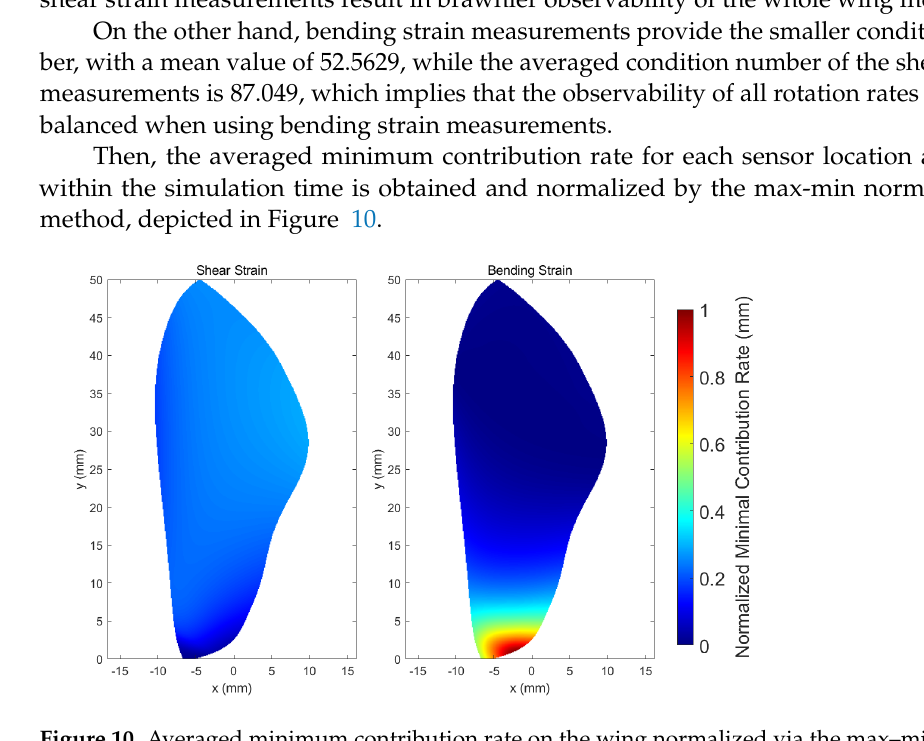
Figure 10. Averaged minimum contribution rate on the wing normalized via the max–min normal- ization